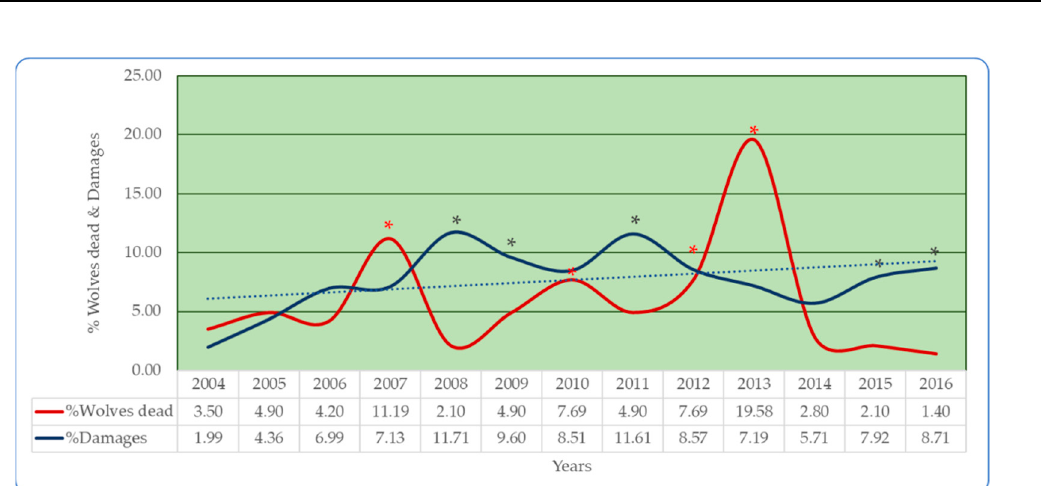
Figure 1. Relationship between percentages of dead wolves and damage caused by the canid. The asterisk indicates significant differences ( p < 0.01) between the years compared.